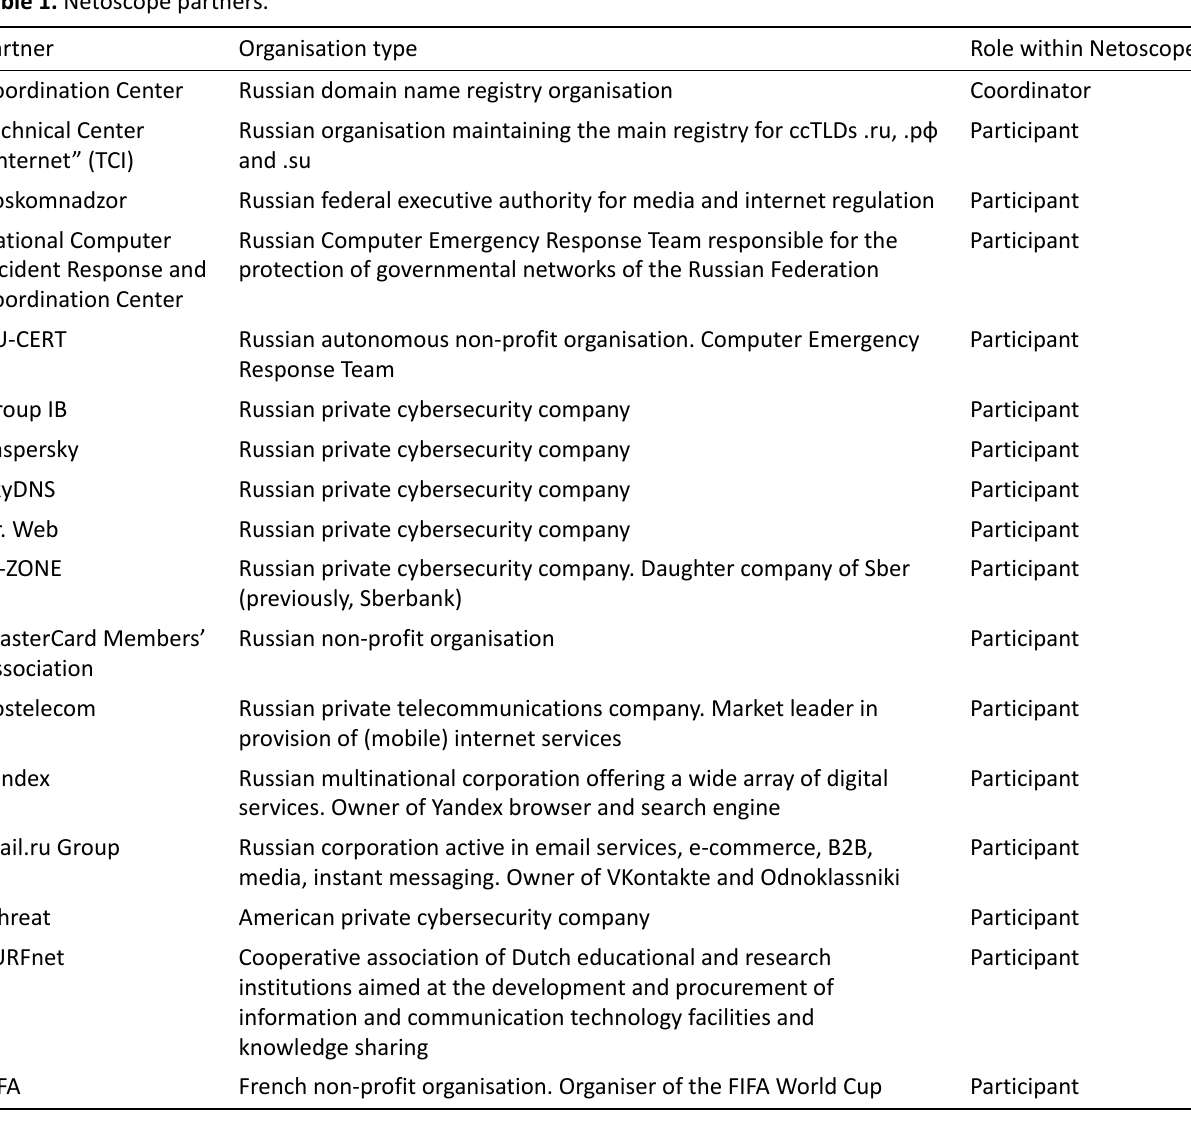
Table 1. Netoscope